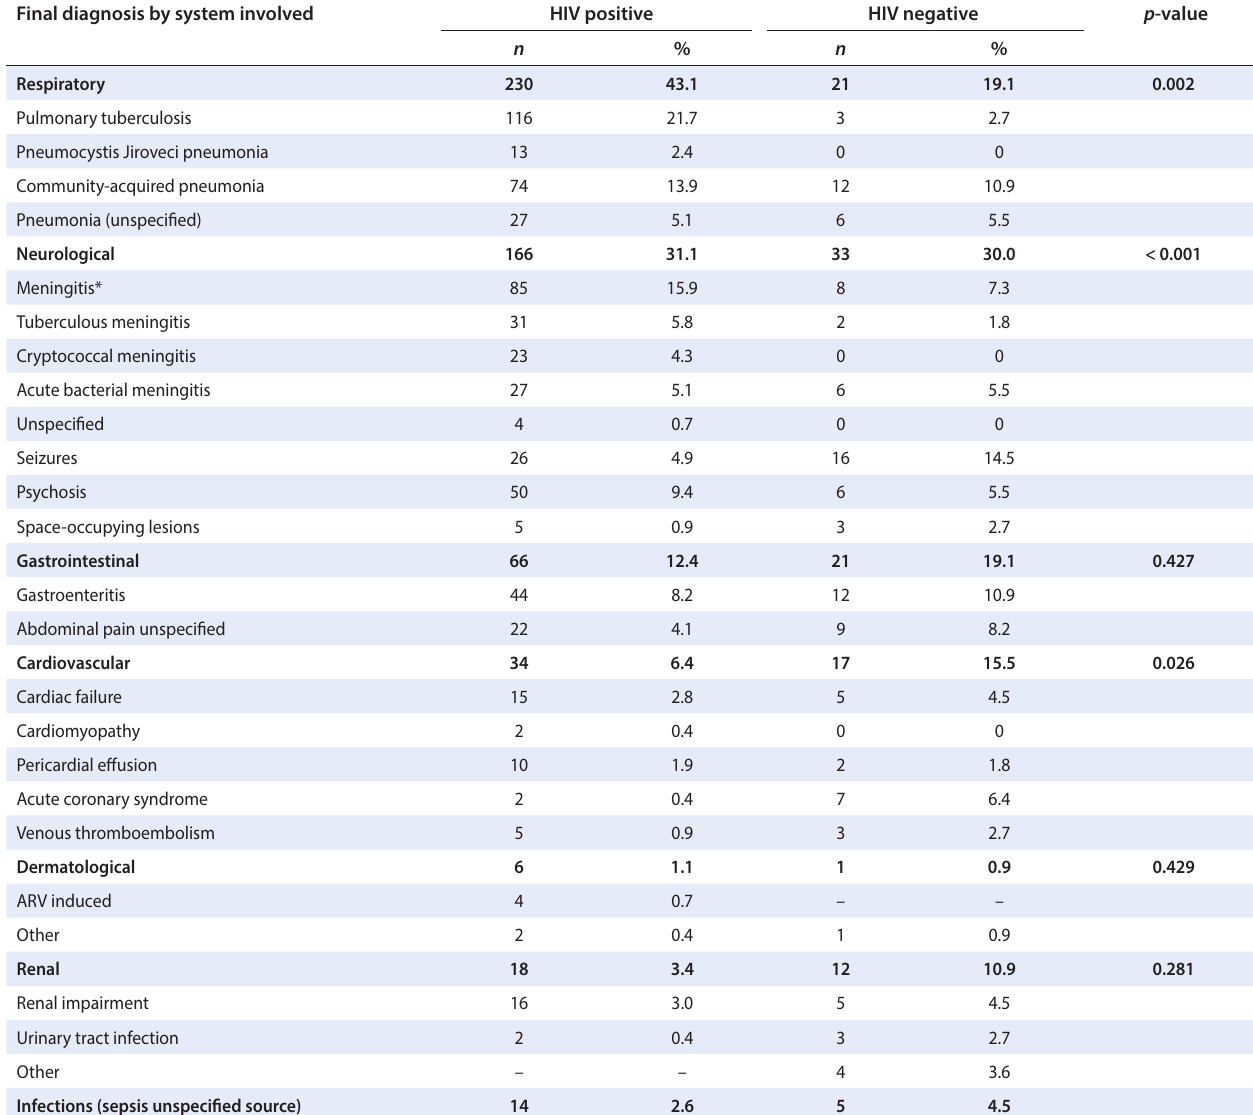
Note: *Meningitis subdivided into specific